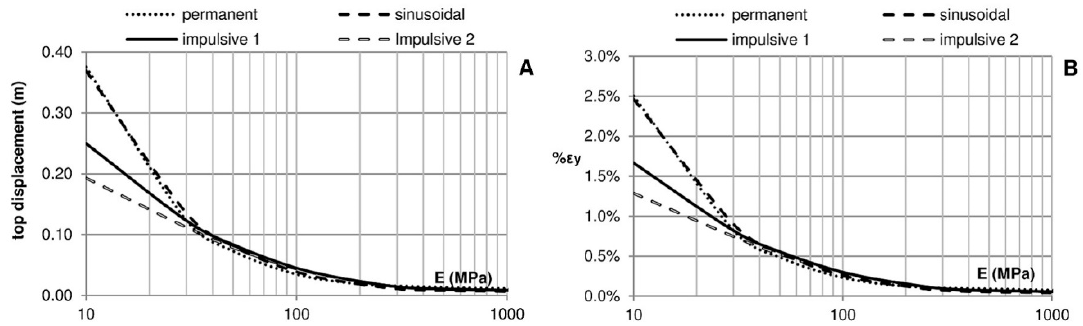
Figure 12. ( A ) Movement on the top of the crown wall; ( B ) maximum vertical deformation of the foundation.